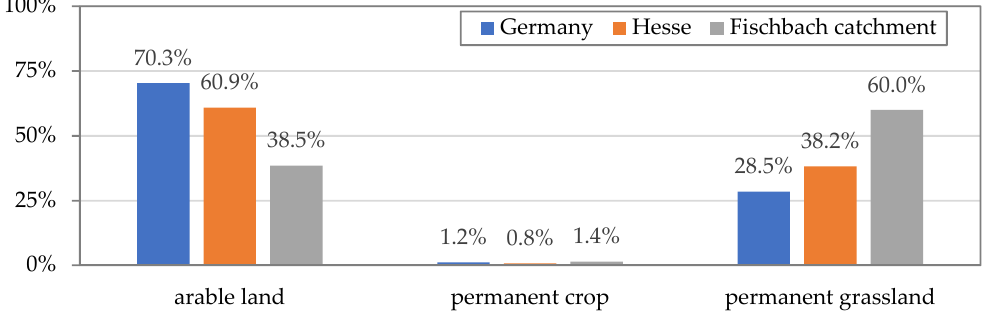
Figure 4. Comparison of shares for different types of areas with agricultural use for the regions Germany, Hesse, and the Fischbach catchment in 2019; data source: [40,61].